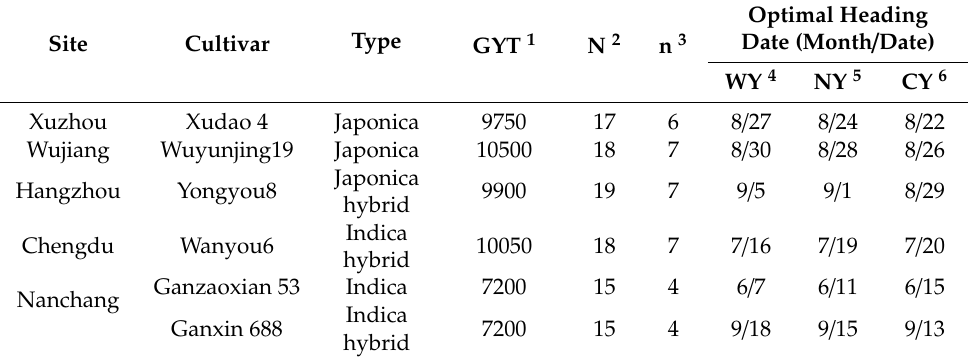
Table 1. Main parameters as input values for simulating planting dates in field experiments.